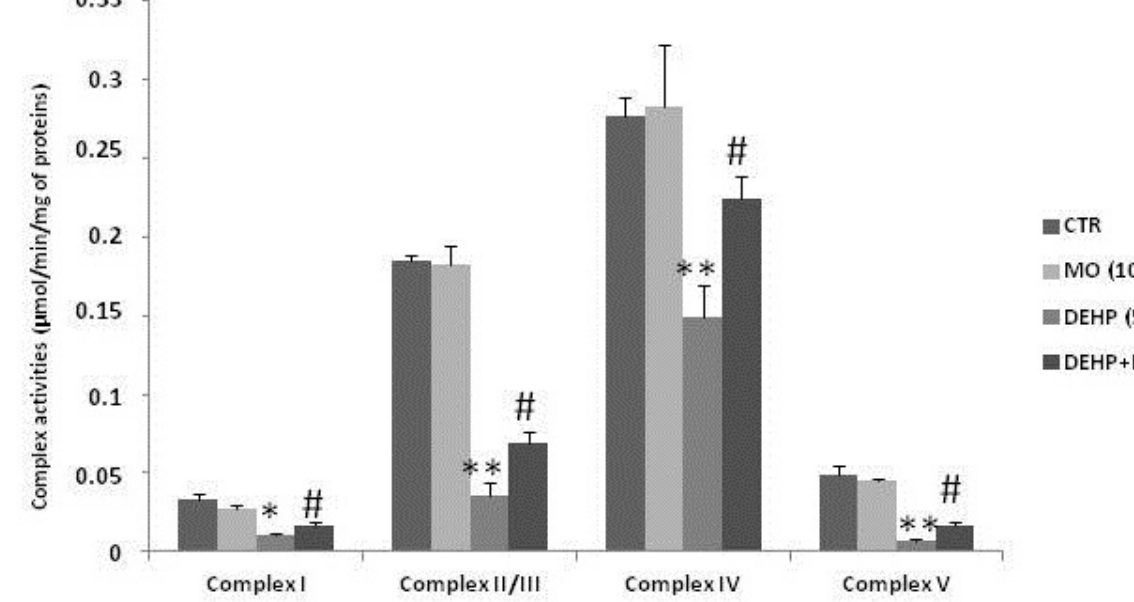
Figure 5. Effect of MOe on DEHP-induced mitochondrial dysfunctions. SH-SY5Y cells were pretreated with MOe (100 µ g/mL) for 2 h before DEHP treatment for 24 h (55 µ M). Enzymatic activities of respiratory chain complexes I, II–III, IV, and V were assayed spectrophotometrically. Data are expressed as the mean ± SD of three separate experiments. * p < 0.05, ** p < 0.01 vs. control, and # p < 0.05 vs. DEHP